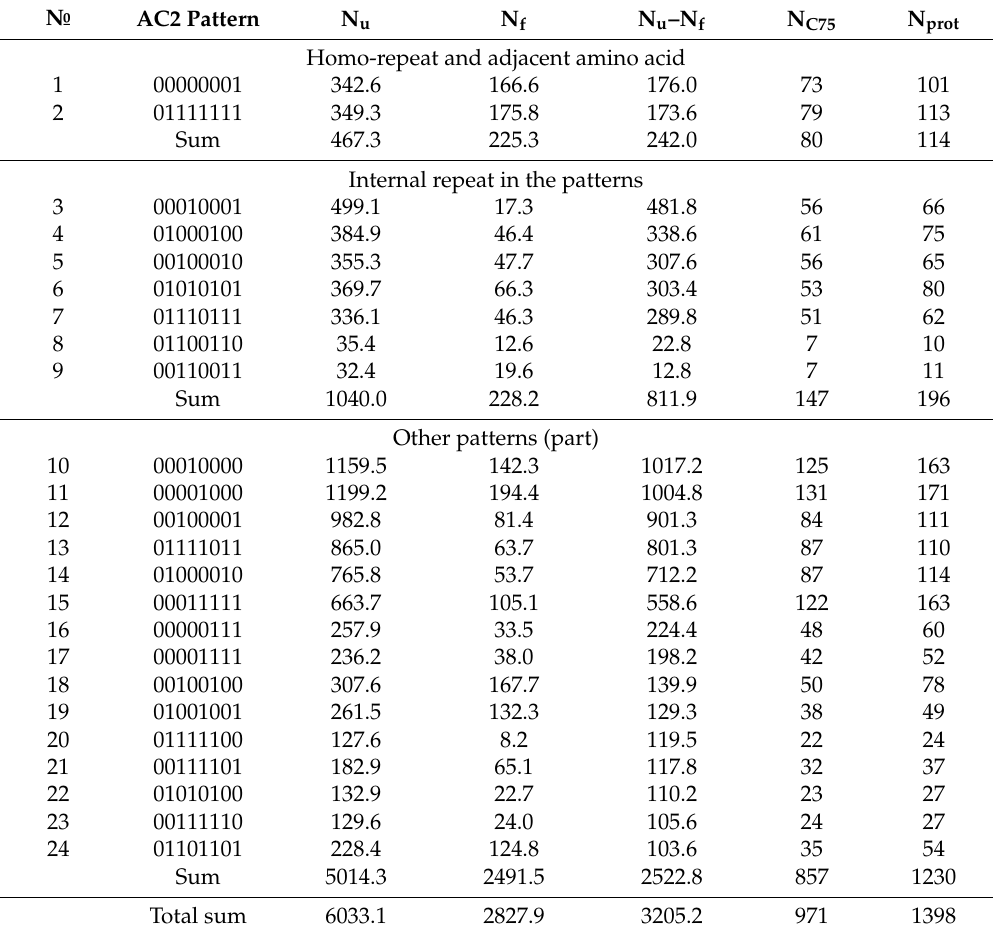
Table 1. Comparison of data for di ff erent AC2 patterns